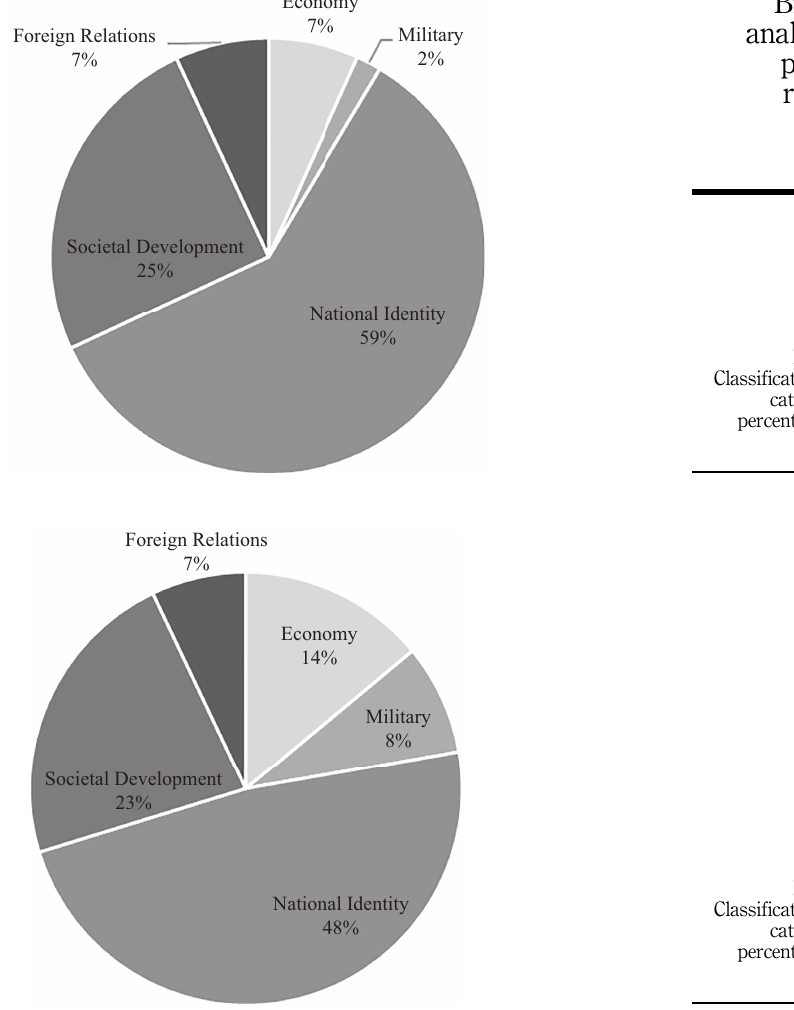
Figure 1. Classification of five categories by percentage – U.S.